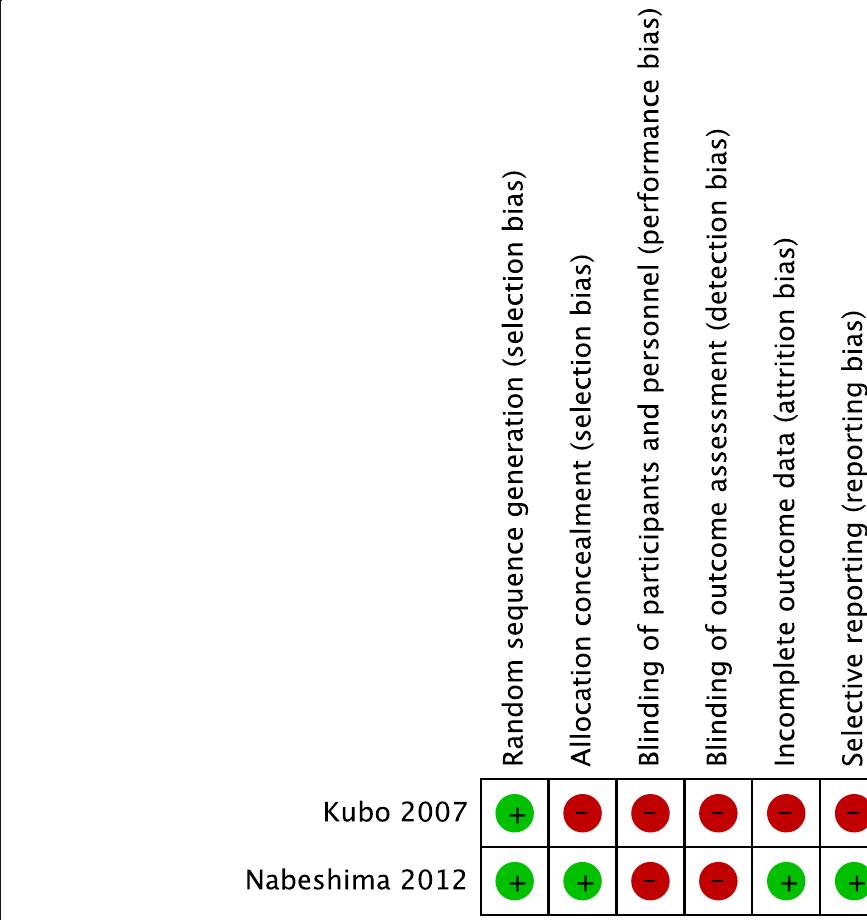
Table 1 Risk of bias summary for non-randomised studies Study Confounding Participant